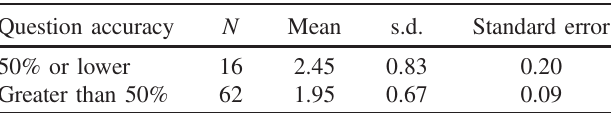
TABLE IV. Descriptive statistics of time spent making predictions for PER